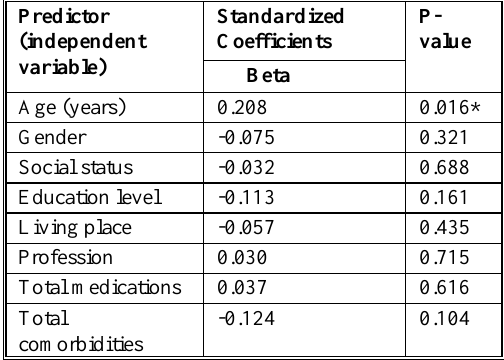
Table 5. Multiple linear regression of factors